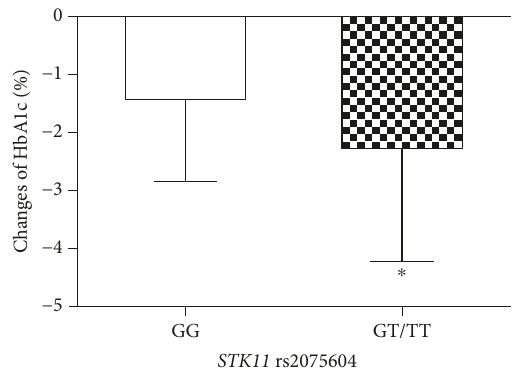
Figure 1: The decreased level of HbA1c in T2DM patients with di ff erent STK11 rs2075604 genotypes after metformin treatment. Data are shown as mean ± SD. ∗ P < 0 05 compared with the GG genotype group ( n = 94 ).